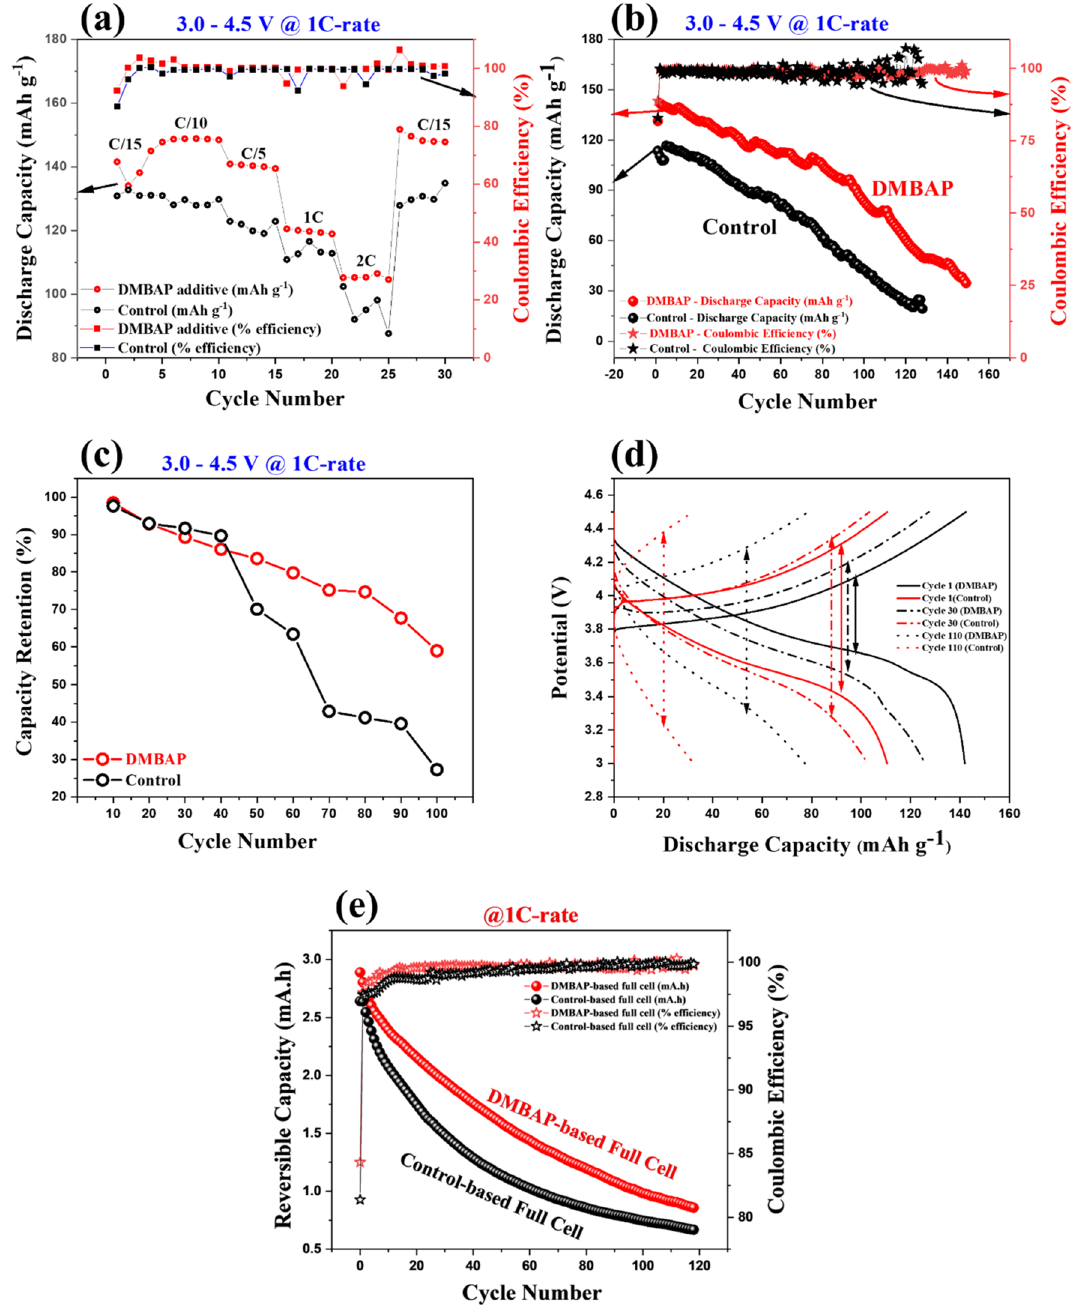
Figure 3. Charge–discharge studies. ( a ) Comparison between charge–discharge performance of control system and DMBAP-based cathodic half-cell at varying current-rates (rate studies), ( b ) long cycling performance of DMBAP-based cathodic half-cell at 1C rate against the control system with no additive, ( c ) comparison of capacity retention between the DMBAP additive-based half-cell and control system, ( d ) comparison of overpotential between the control system and DMBAP-based cathodic half-cells during long cycling at 1C-rate, and ( e ) reversible capacity versus cycle number comparison between DMBAP-based and control electrolyte- based full cells,